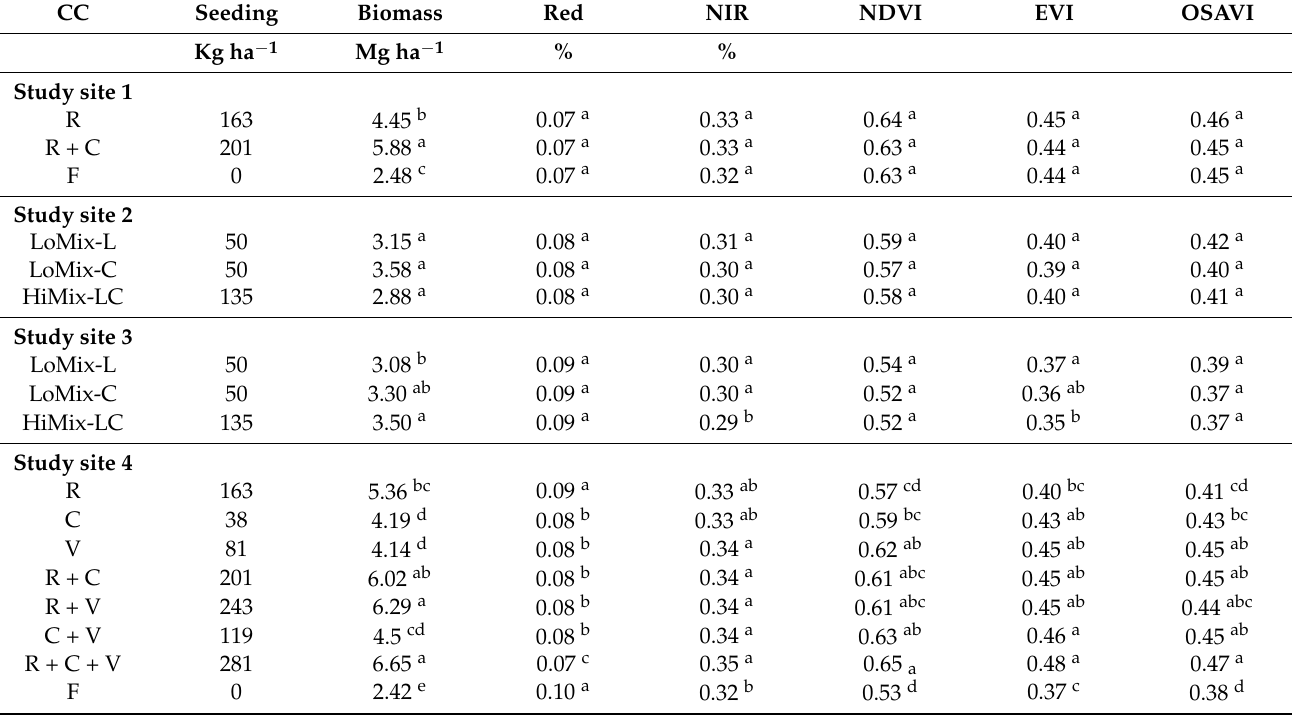
Table 4. Least square means of selected bands and indices from Planet imagery during the month of March and cover crop biomass after analysis of variance